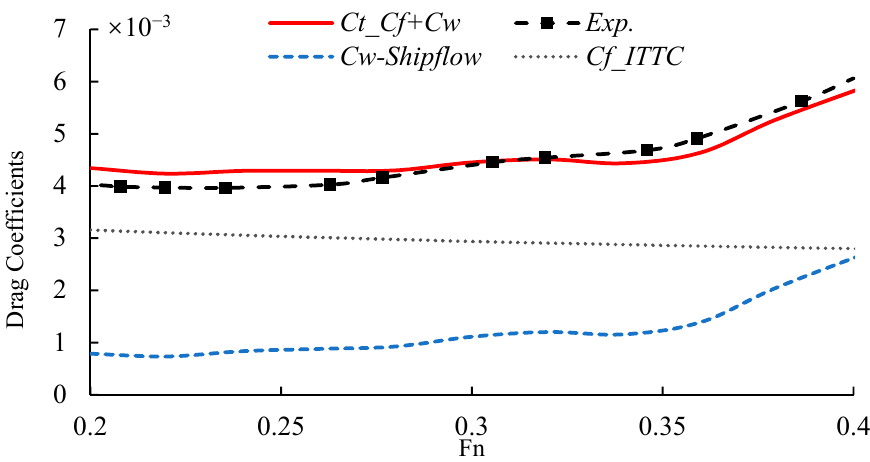
Figure 13. SHIPFLOW meshes of DTMB 5415. Figure 13. Data comparison chart of DTMB